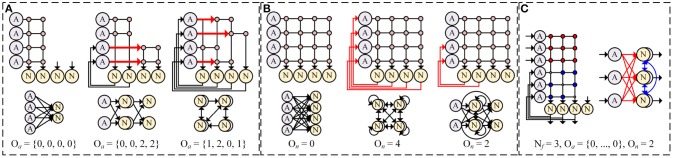
Network compositions with (A) different axonal offsets (Nf = 2) and (B) different neuronal offsets (Nf = 4), and (C) an example of implemented lateral inhibitory layer (Nf = 3).